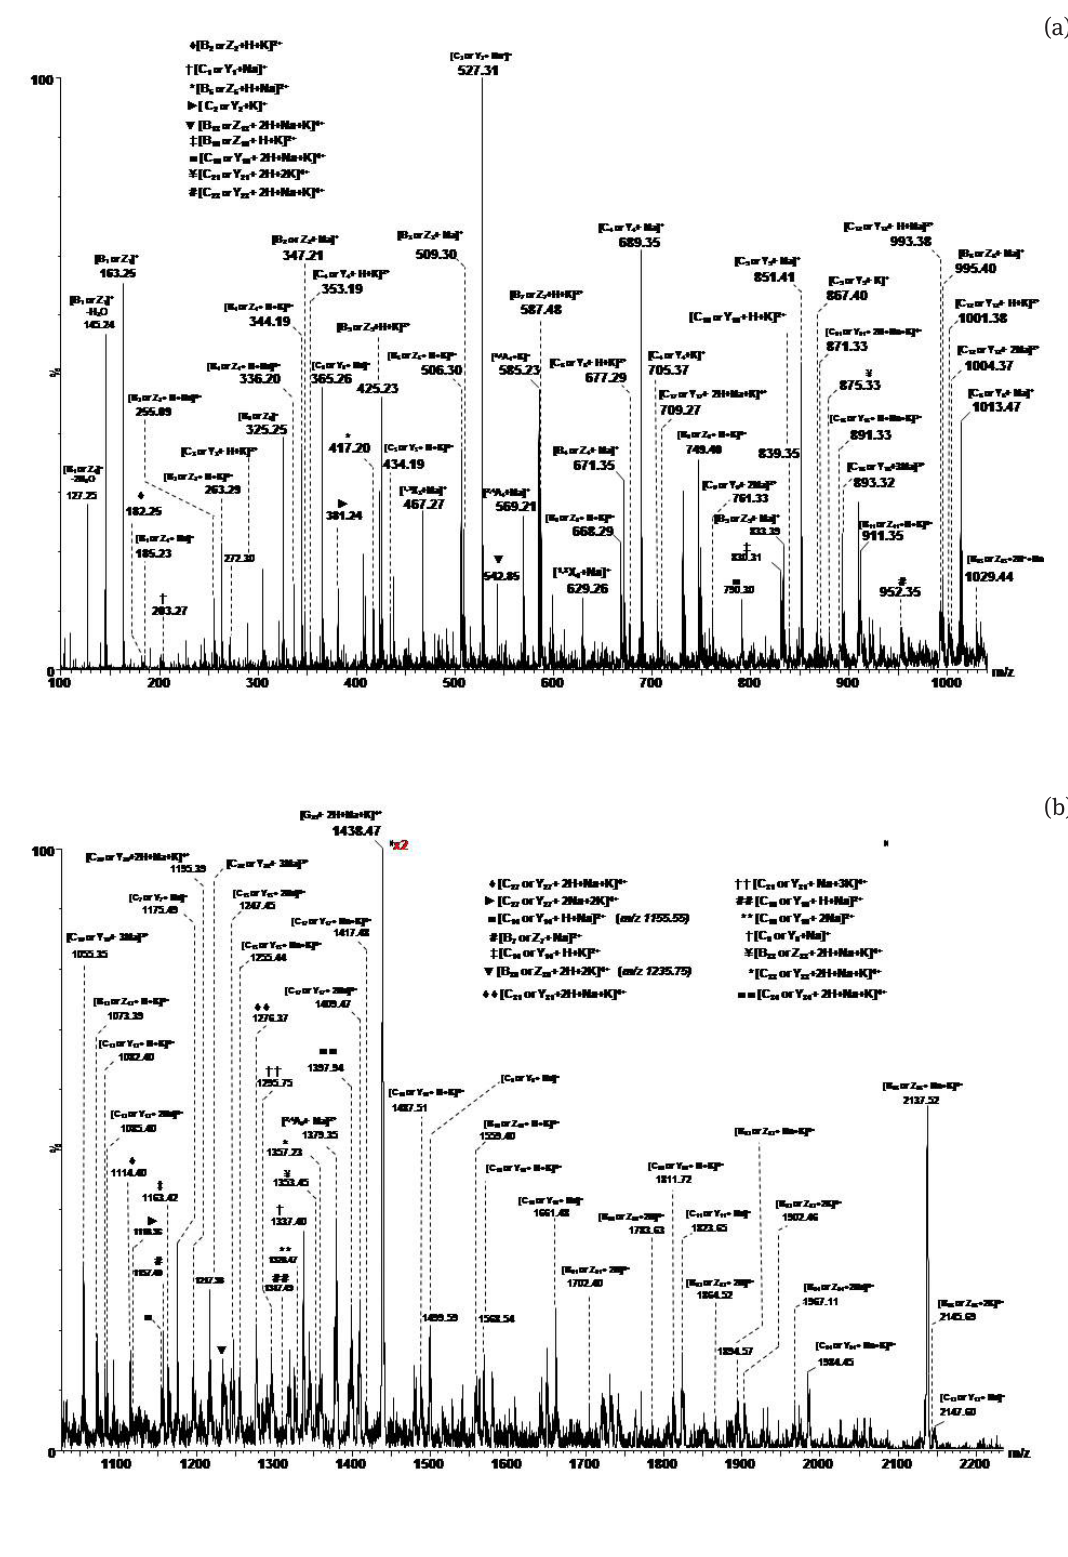
+2H+Na+K] 4+ in Dex 4. Cone voltage 50 V. Capillary 35